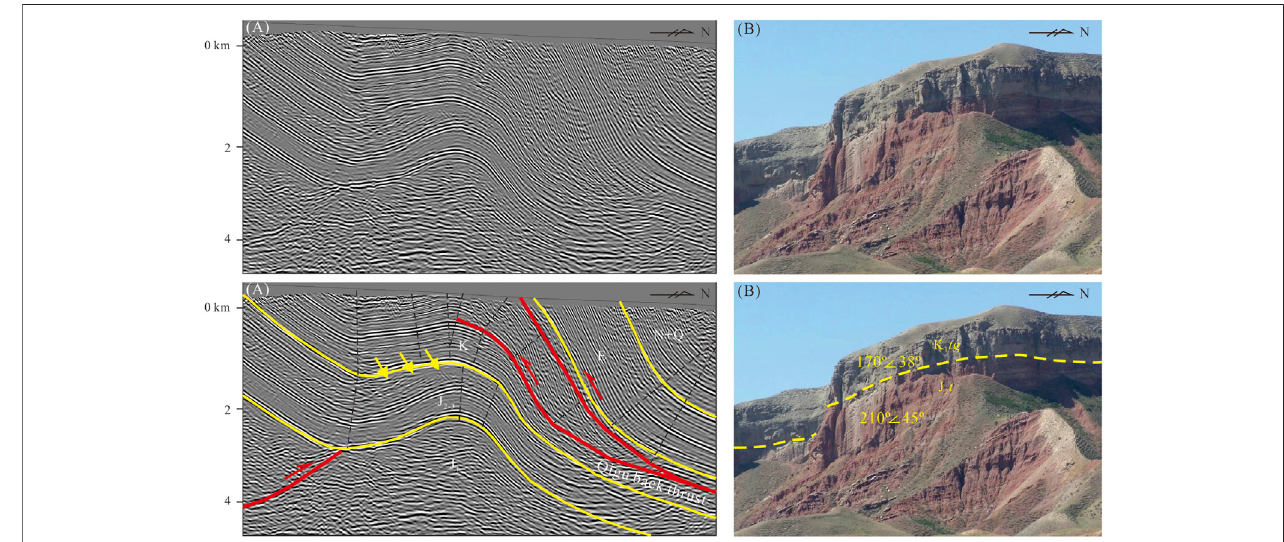
FIGURE 4 | Seismic re fl ection (A) and outcrop (B) features of K/J unconformity in the Qigu anticline.